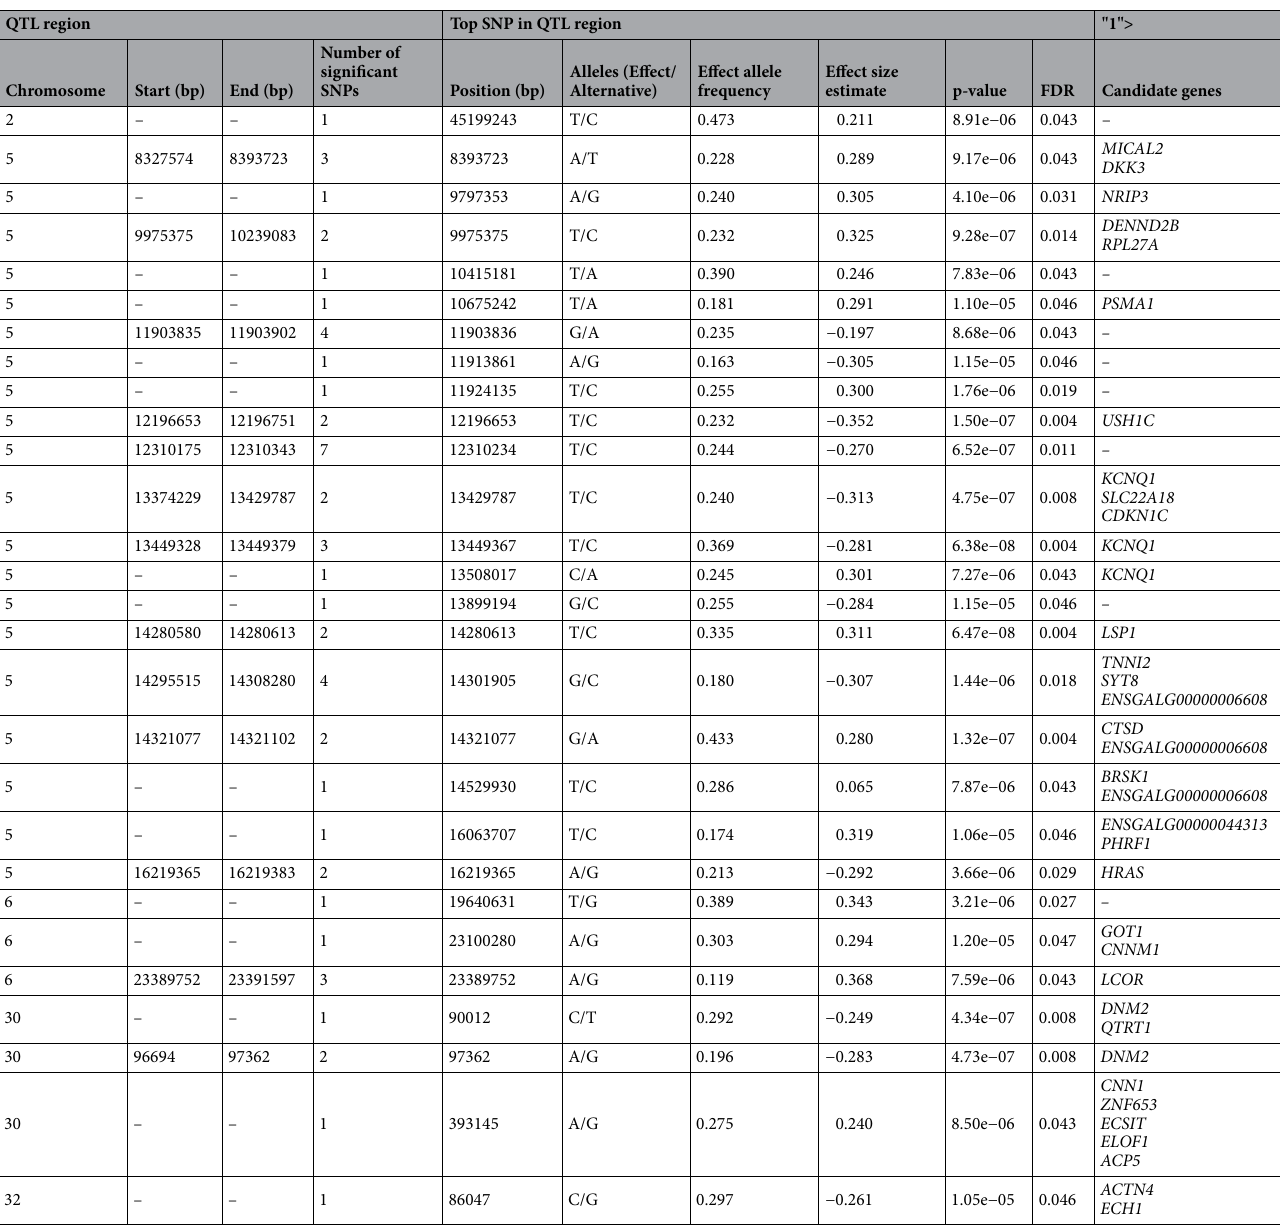
Table 3. Wooden Breast QTL regions containing SNPs with FDR adjusted p -values less than 0.05. Results of single-marker genome-wide association analysis using all birds. Candidate genes include protein-coding genes located within 5000 bp upstream or downstream of the QTL start or end site,